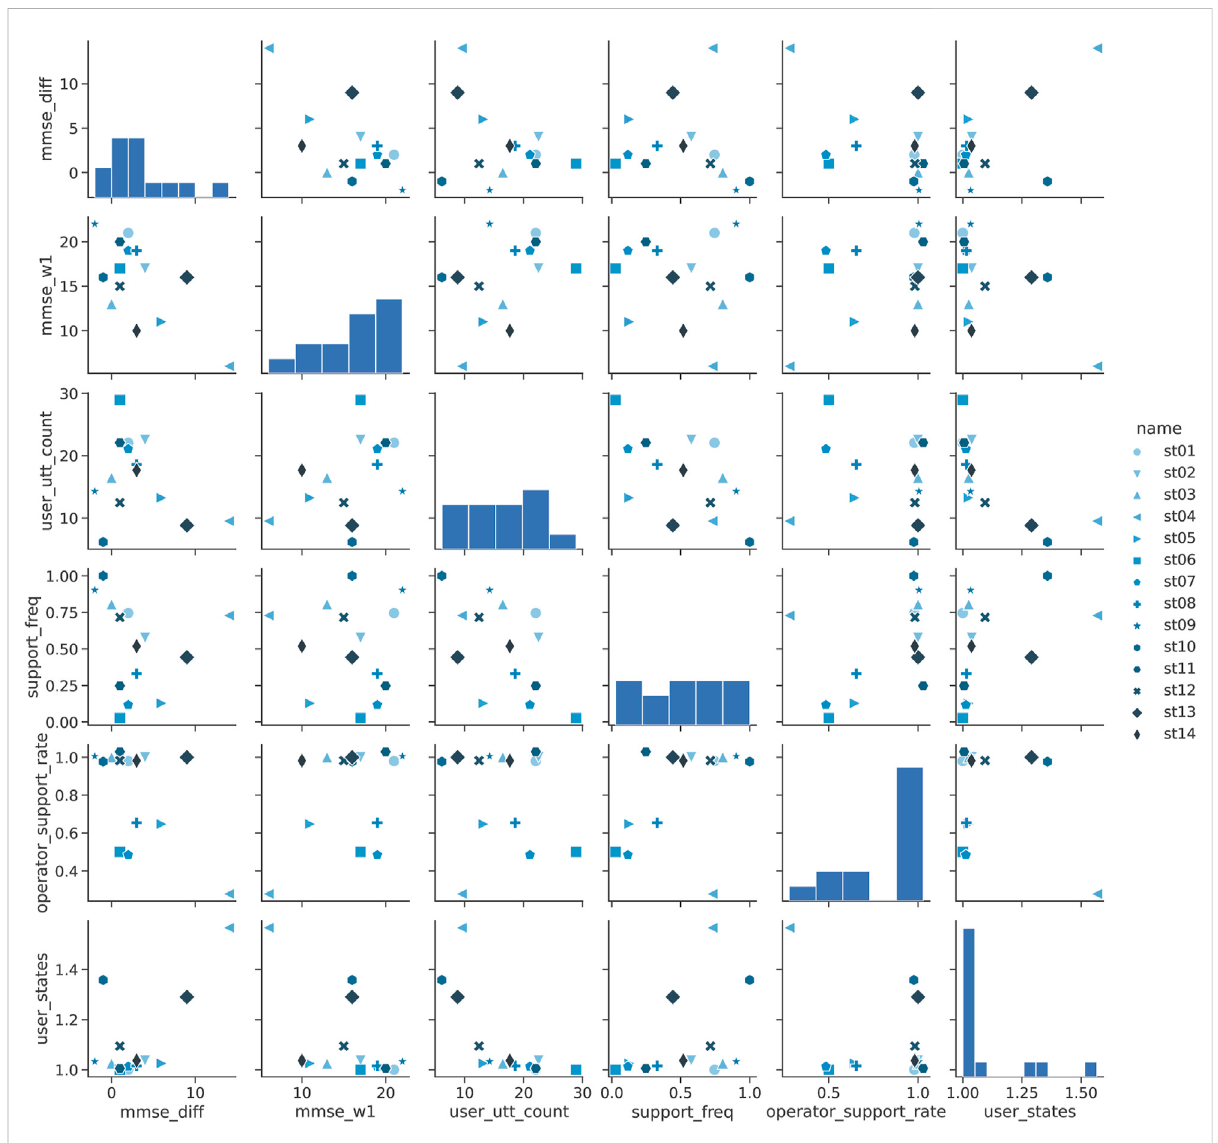
FIGURE 10 Pairplot analysis of MMSE in Shiritori